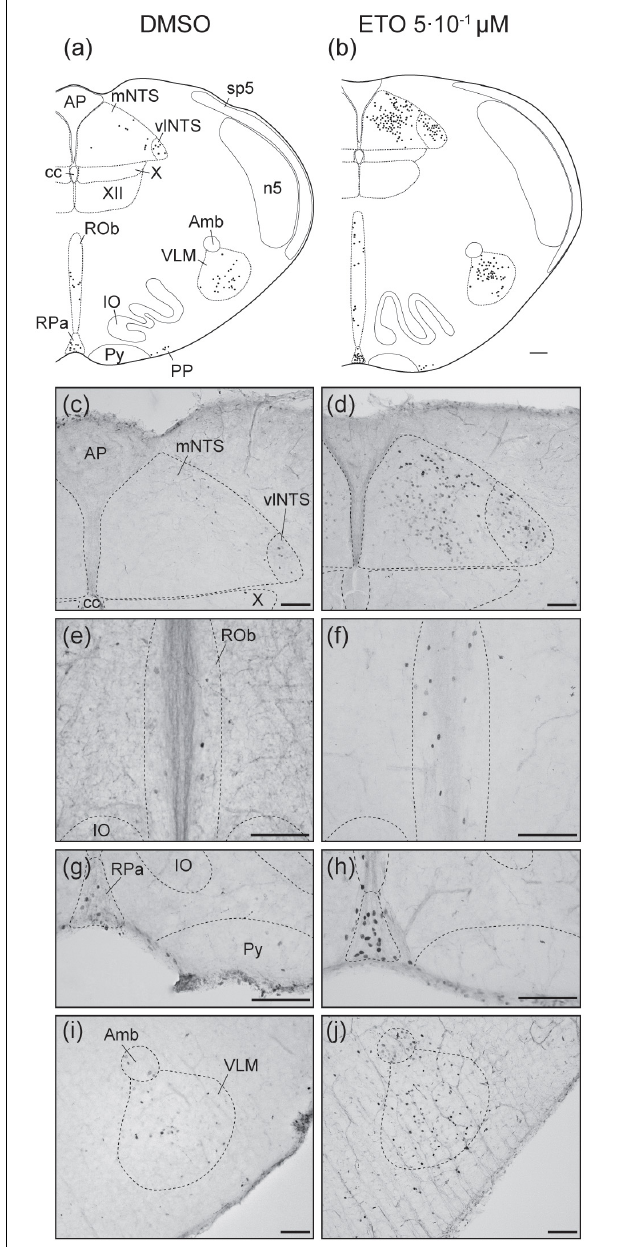
FIGURE 3 | Etonogestrel increases or enhances increase in prolonged metabolic acidosis-induced c-fos expression in medullary respiratory-related areas. Drawings representing distribution of cells immunoreactive for c-FOS during prolonged metabolic acidosis (black points) in medulla oblongata under DMSO (a) or 5 · 10 − 1 µ M etonogestrel (b) exposure. Photomicrographs illustrating metabolic acidosis-induced c-FOS immunoreactivity under DMSO (c,e,g,i) or etonogestrel (d,f,h,j) exposure in mNTS and vlNTS (c,d) , ROb (e,f) , RPa (g,h) , and VLM (i,j) . Scale bar = 100 µ m. Abbreviations: ambiguus nucleus (Amb), area postrema (AP), central canal (cc), etonogestrel (ETO), hypoglossal nucleus (XII), inferior olives (IO), median part of the nucleus of the tractus solitarius, (mNTS), parapyramidal group (PP), obscurus (ROb) and pallidus (RPa) raphe nuclei, pyramidal tract (Py), ventrolateral medullary reticular nucleus (VLM), ventrolateral part of the nucleus of the tractus solitarius (vlNTS), and dorsal motor nucleus of vagus